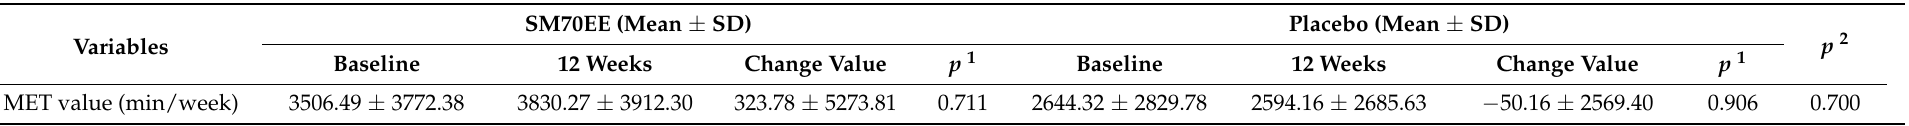
Table 10. Changes in metabolic equivalent of task (MET) results before and after 12 weeks of SM70EE product